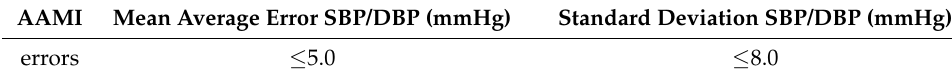
Table 5. Performance requirements in AAMI standard.